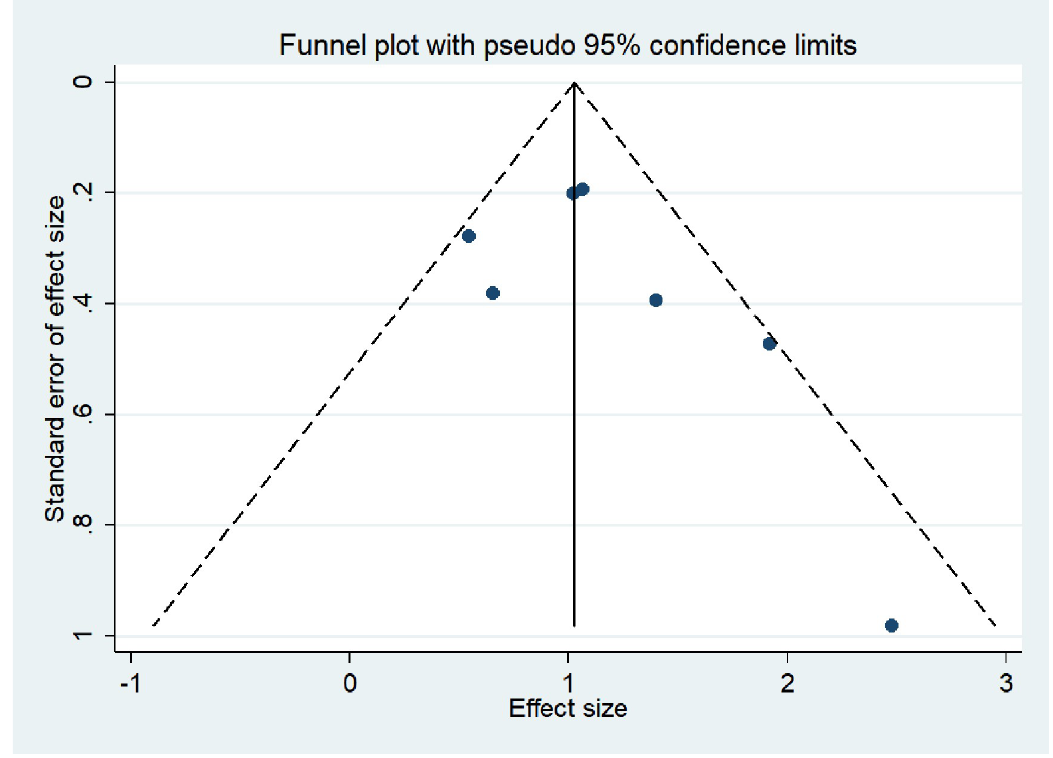
Fig 5. Deeks’ funnel plots for publication bias. Deeks funnel plot assessment test evaluates the potential publication bias for interferon-gamma release assays on OATB. The plot shows the symmetric distribution of the log of diagnostic odds ratios against the inverse root of effective sample sizes (ESS), indicating the absence of any publication